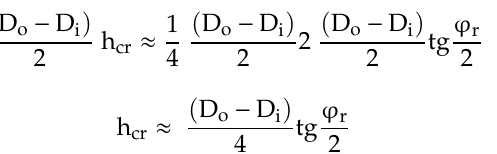
Figure 8. Arrangement of rotor poles and rotor yoke.